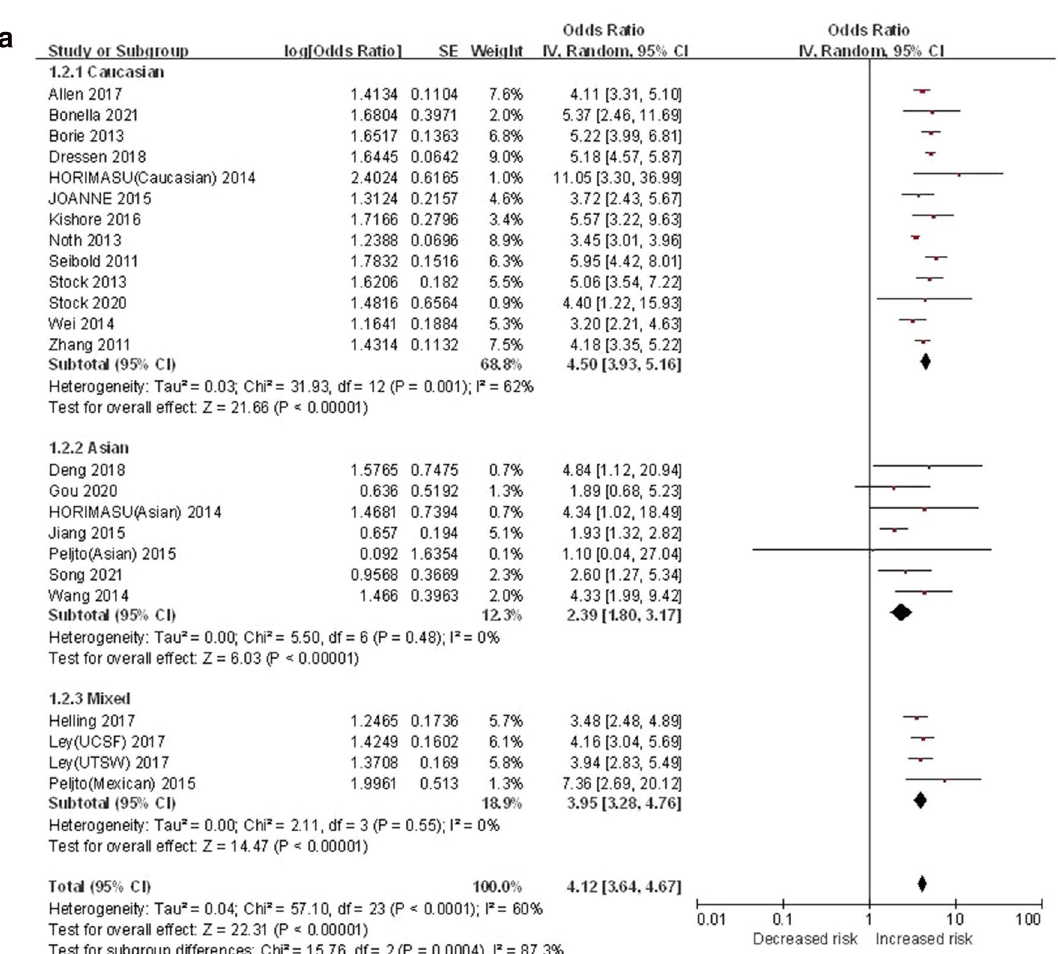
Figure 2. The T vs. G model was used to evaluate the correlation between MUC5B gene polymorphism and IPF susceptibility. ( a ) Forest plot of T vs. G genetic model. ( b ) Trial sequential analysis of MUC5B polymorphism and IPF risk using the allelic model (T vs. G) (Adjusted Boundaries Print). The combined sample size (N = 32,884) exceeded RIS (N = 26,956), the cumulative Z curve crossed the conventional boundary and the TSA boundary, and the association was established in advance. ( c ) Inverted funnel chart of T vs.